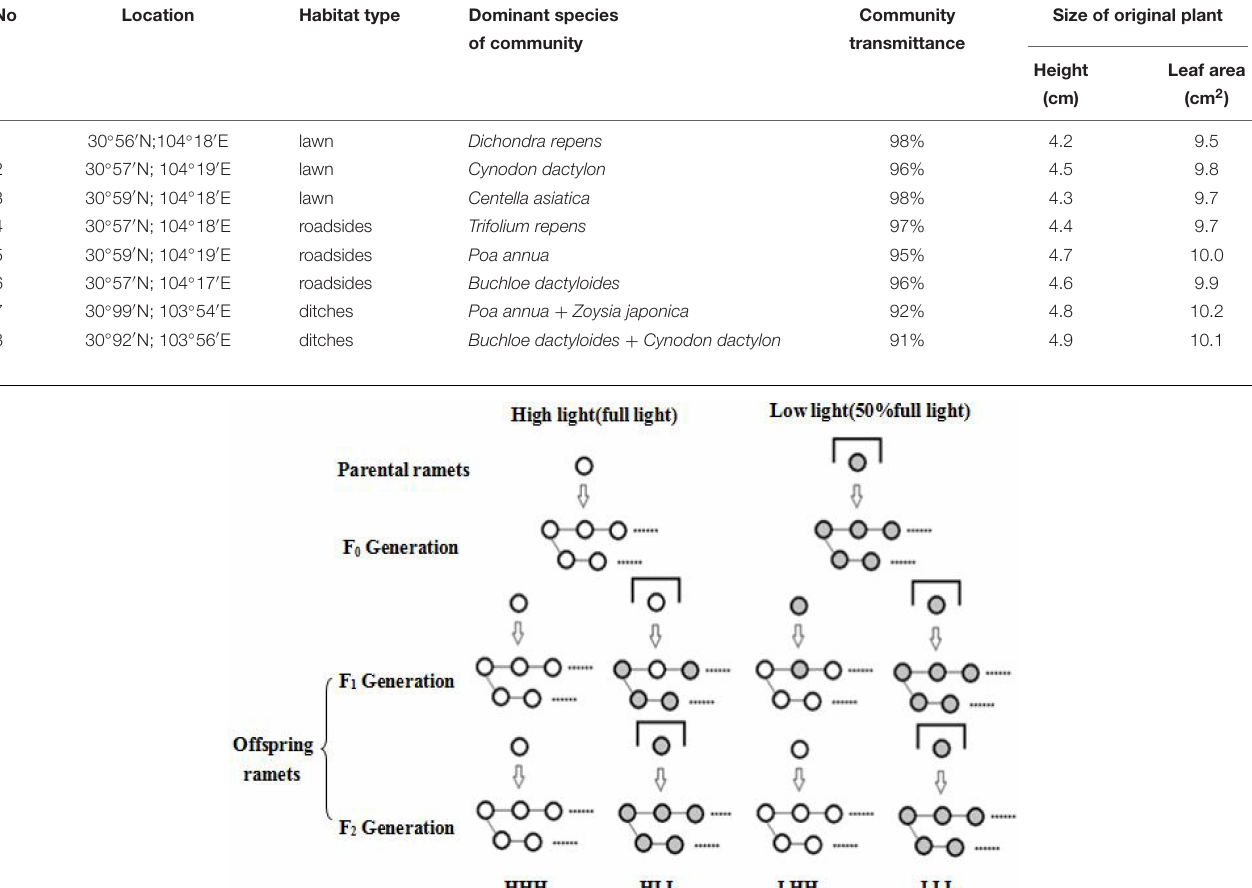
TABLE 1 | Basic information on original plants of Centella asiatica in the experiment.